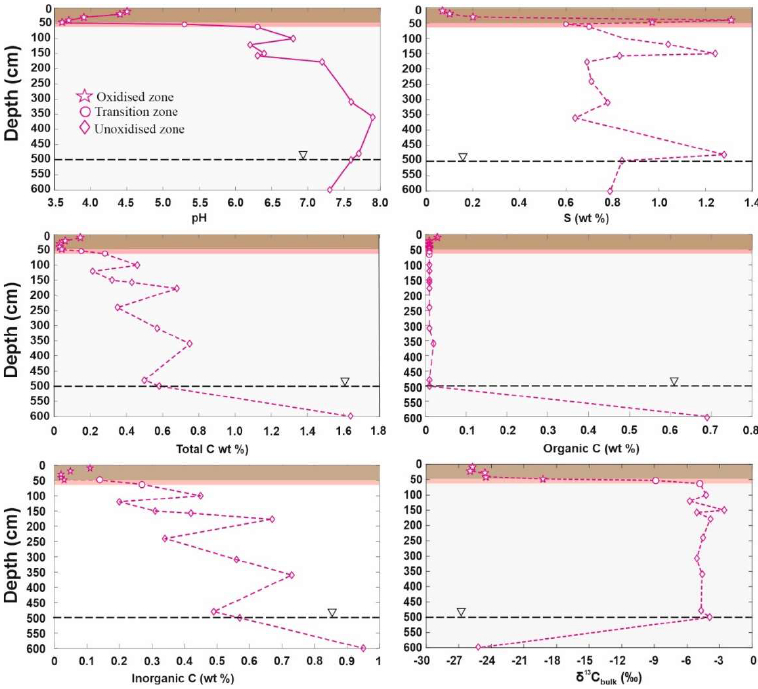
Figure 2. Vertical distribution of the chemical and isotopic (δ 13 C) composition of the tailings.